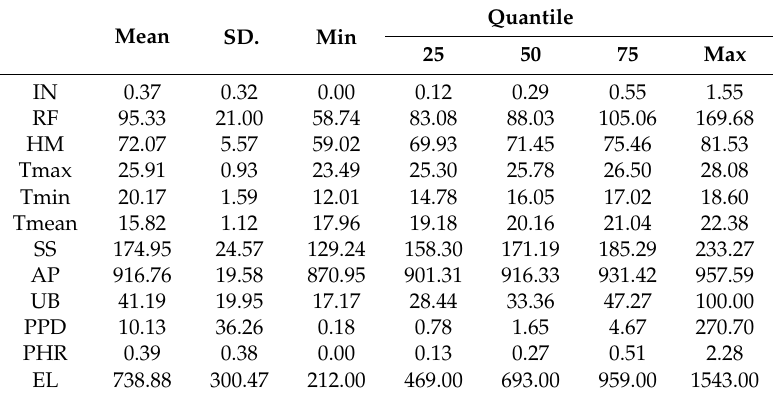
Table 2. JE incidences and social and -climate variables in Shaanxi, China (2006–2014).